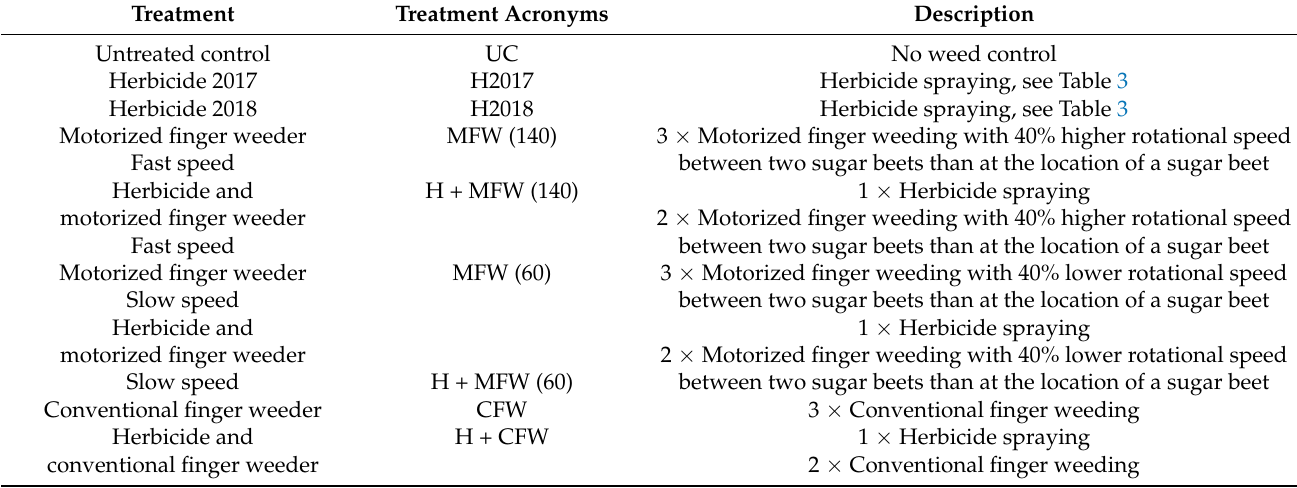
Table 2. Description of the treatments at Ihinger Hof in 2017 and 2018. The tractor driving speed was 1 kmh − 1 for the motorized finger weeders (MFW) treatments and 6 kmh − 1 for the conventional finger weeder (CFW) treatments. The nominal rotational speed (100%) of the MFW at the location of a sugar beet corresponded to a linear speed of 1 kmh − 1